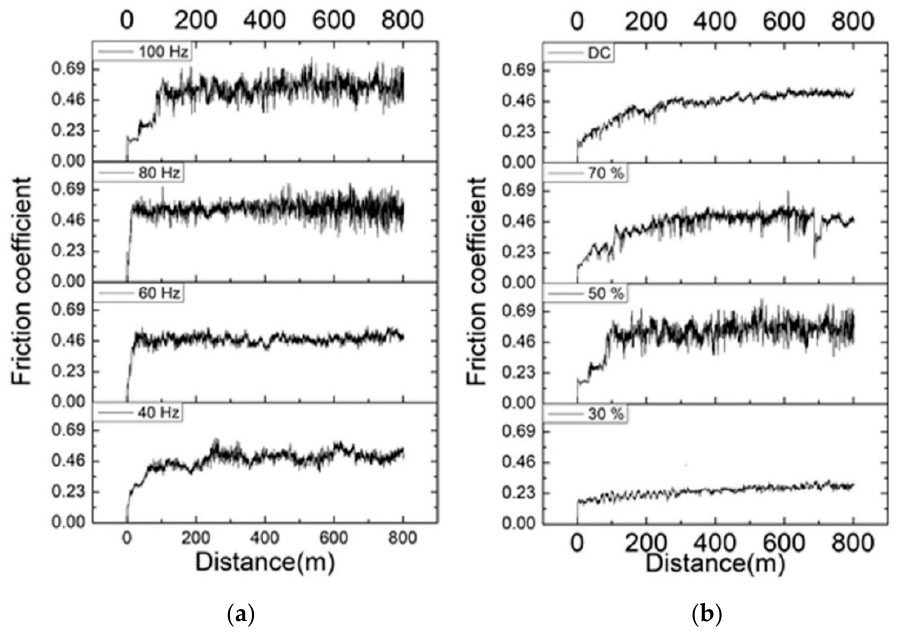
Figure 9. Friction coefficient of the coatings, ( a ) effect of frequency, ( b ) effect of duty cycle.